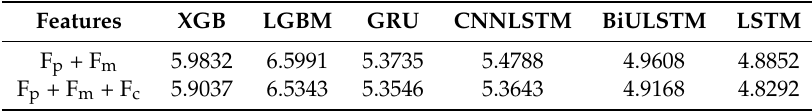
Table 2. Models’ average RMSE values (µg/m 3 ) with/without CMAQ